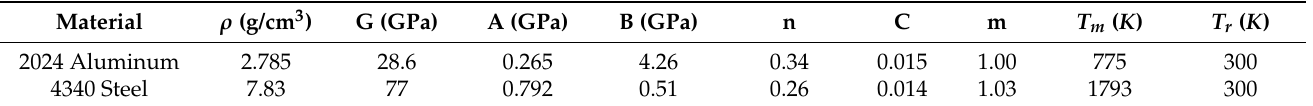
Table 3. Material parameters.